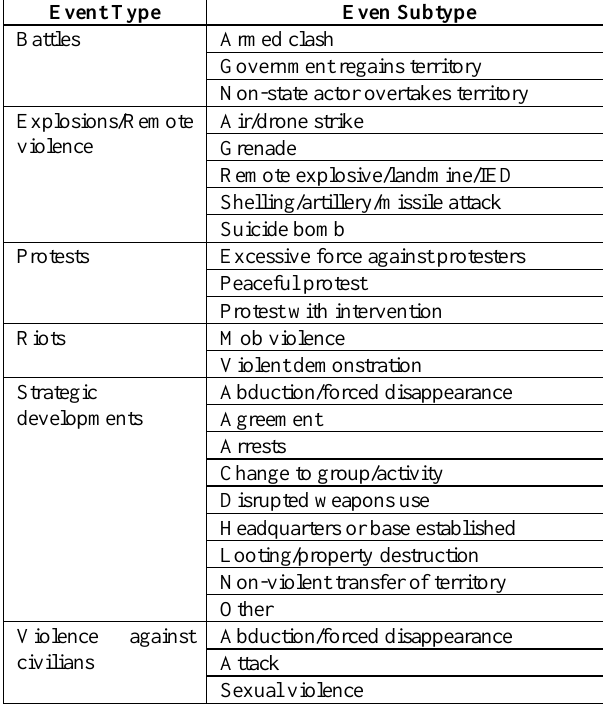
Table 2. Taxonomy of event types and subtypes in ACLED (ACLED. 2021)